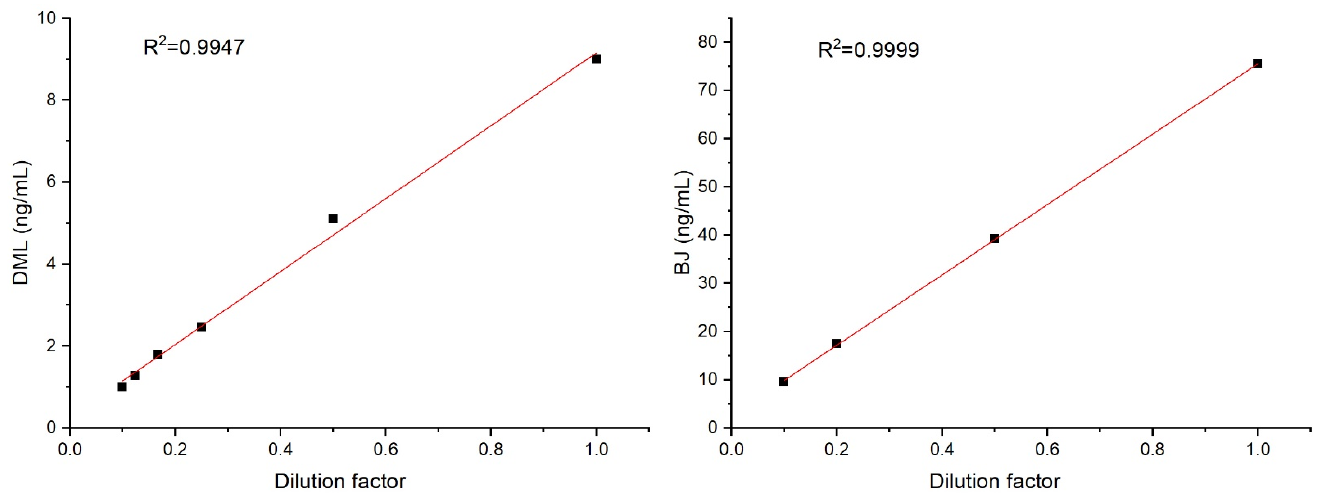
Figure 4. Effect of dilution on black carbon measurement.